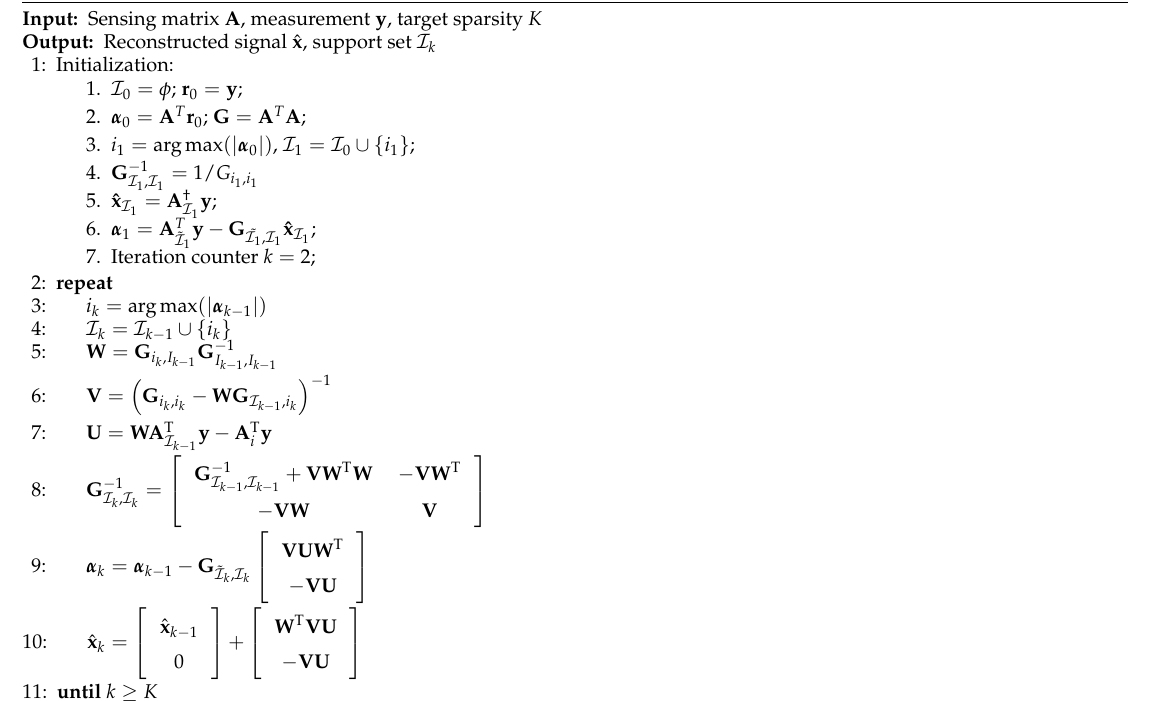
Algorithm 2 Orthogonal Matching Pursuit via Matrix Inversion Bypass